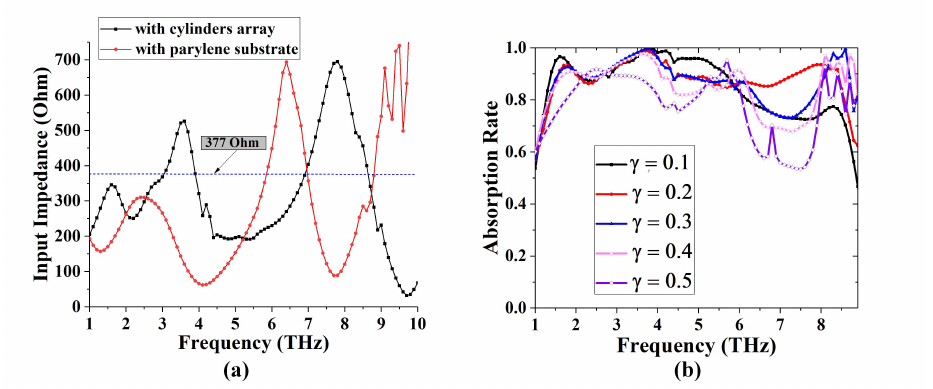
Figure 4. ( a ) Comparison of input impedance with cylinders array and with parylene substrate. ( b ) The simulated frequency responses with different γ .